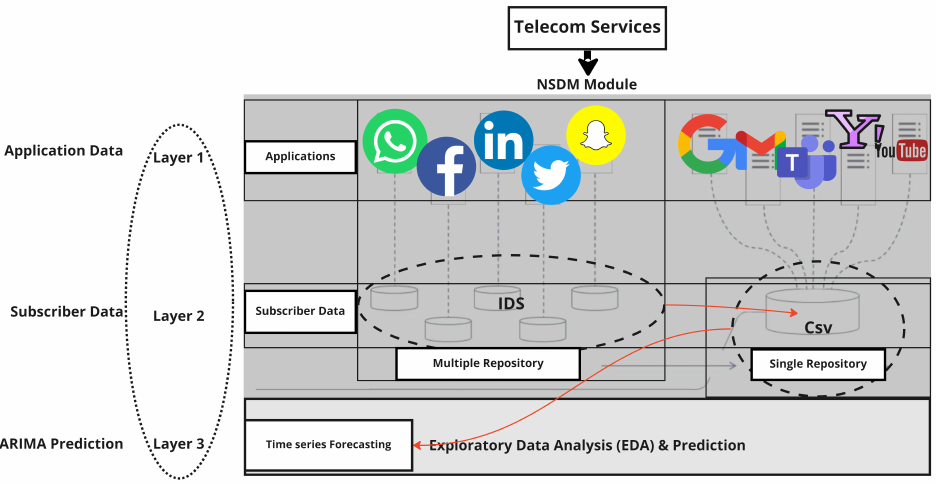
Figure 1. The NSDM